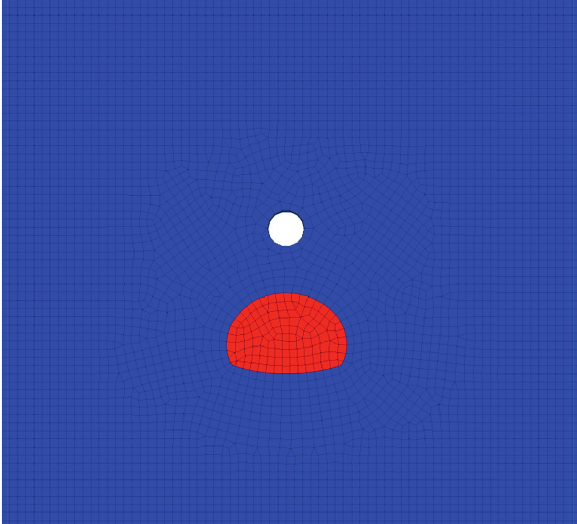
Figure 12: The numerical model of a karst cave above the Wuz- hishan tunnel.